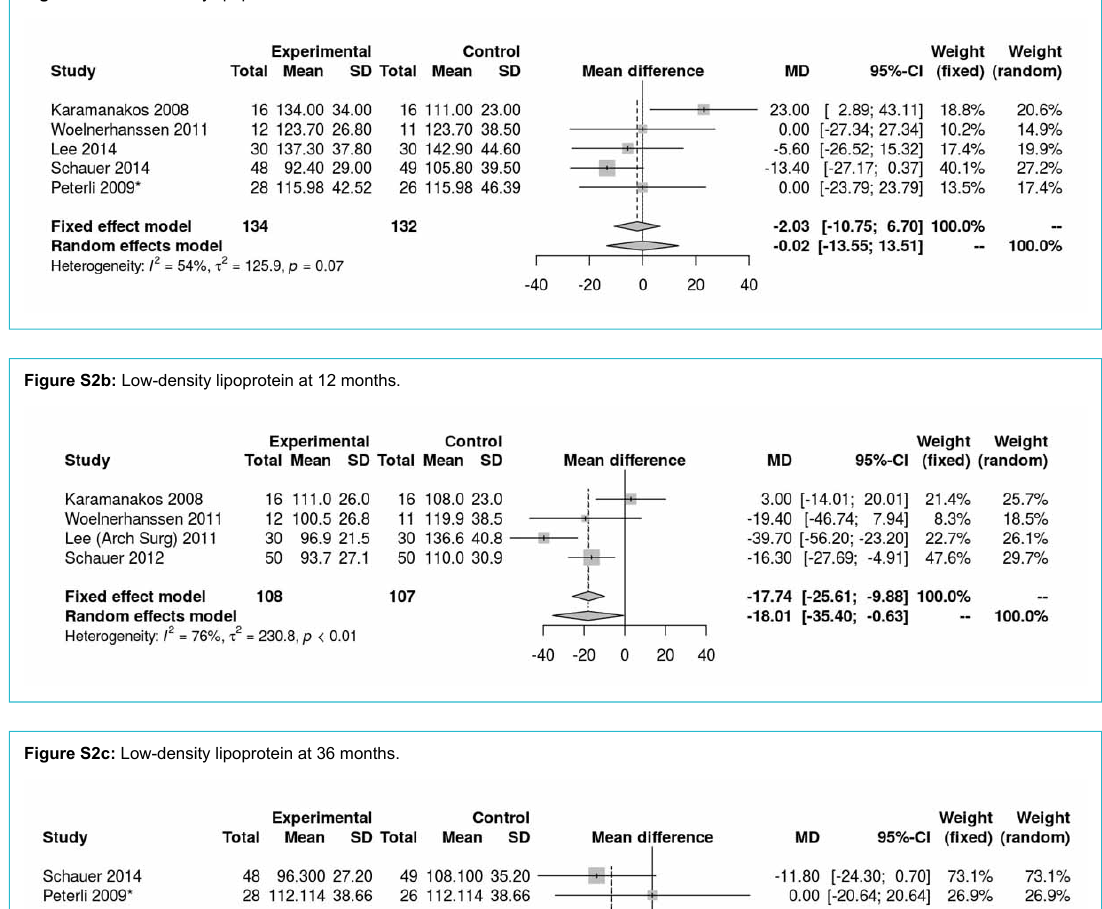
Figure S2a: Low-density lipoprotein at baseline.